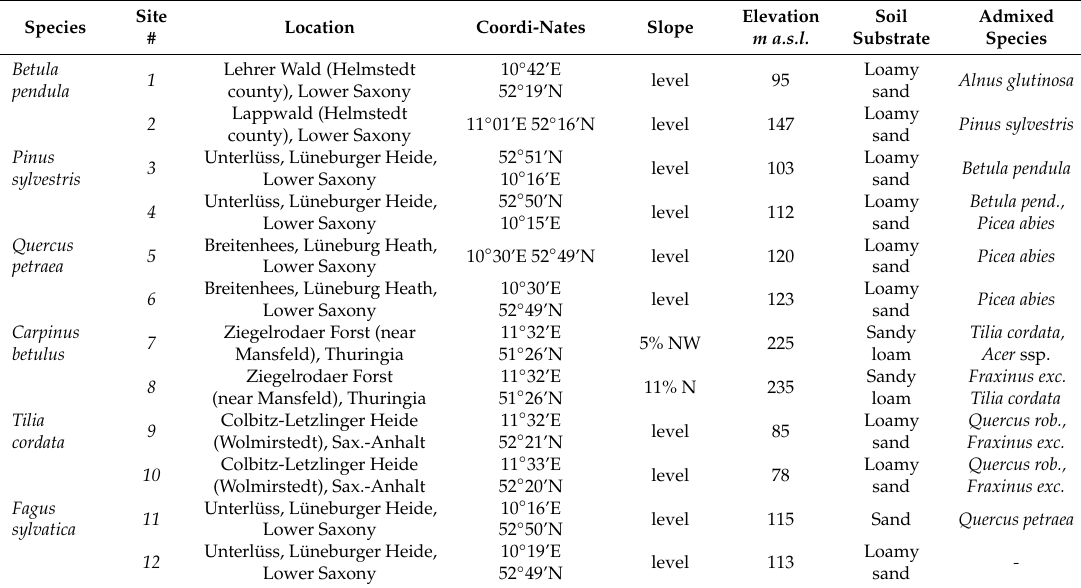
Table 2. Some physiographic characteristics of the 12 study sites (each two per species) in north-west and central